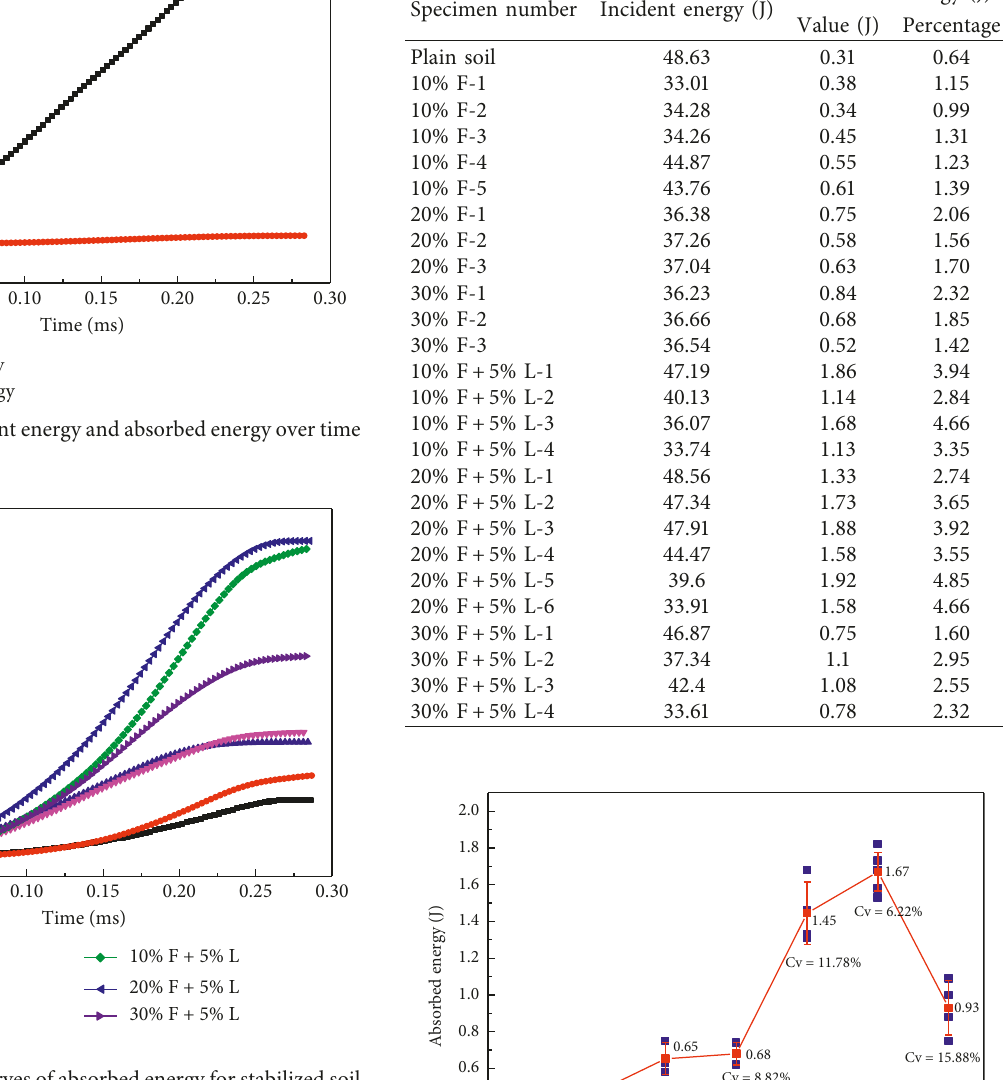
Figure 6: Time-history curves of absorbed energy for stabilized soil with different mix proportions.